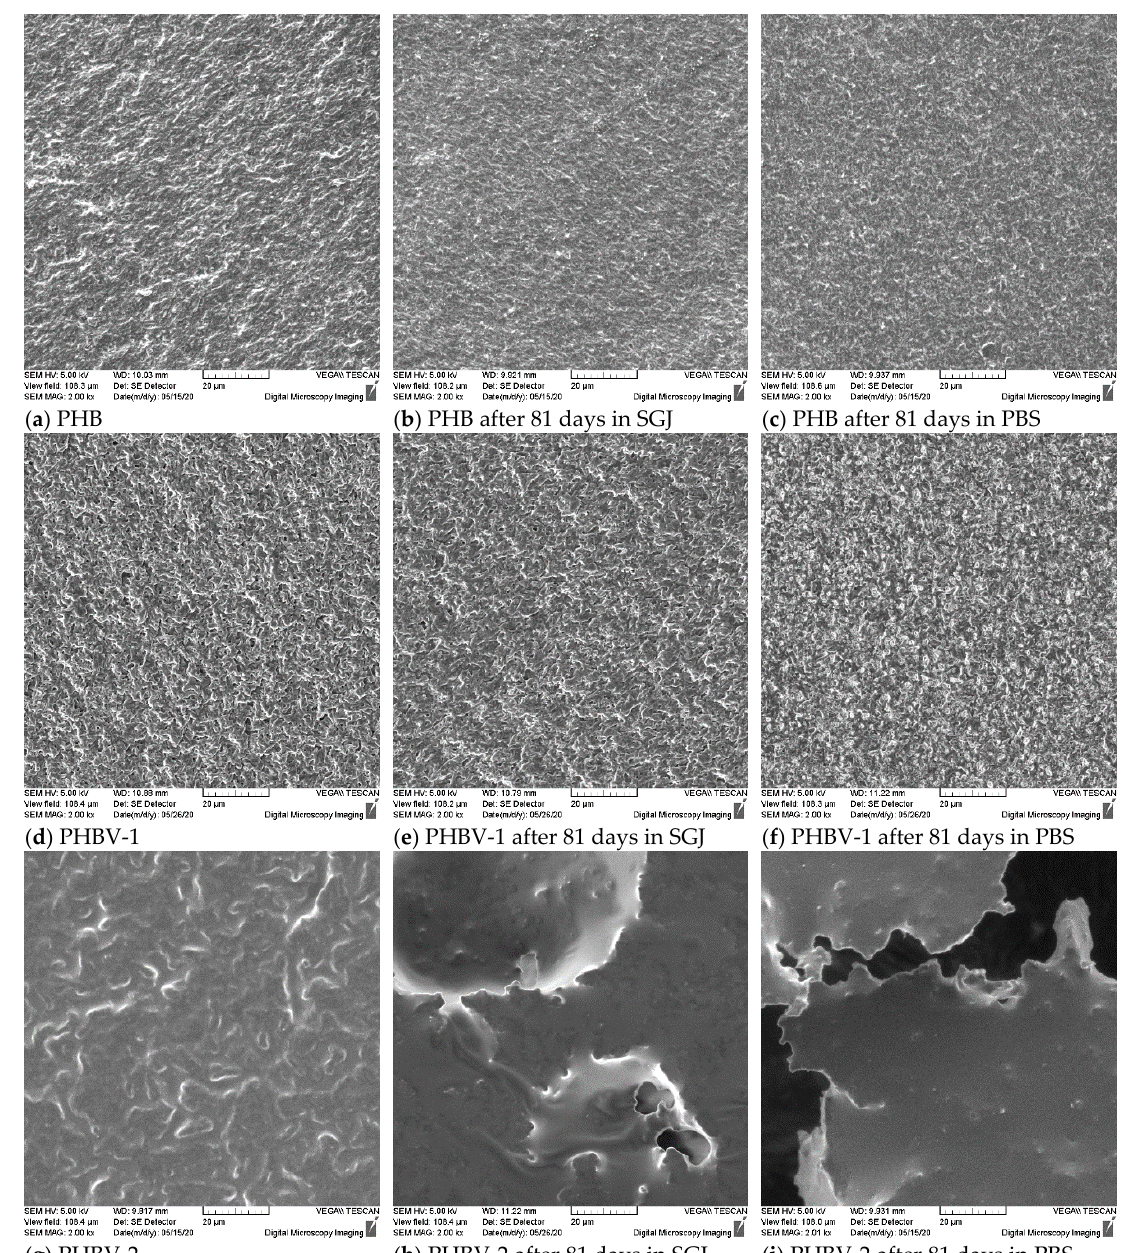
Figure 6. Morphological changes of original PHB, PHBV-1, and PHBV-2 and after 81 days degradation at 37 °C in synthetic gastric juice (SGJ) and phosphate buffer saline solution (PBS) with lipase.